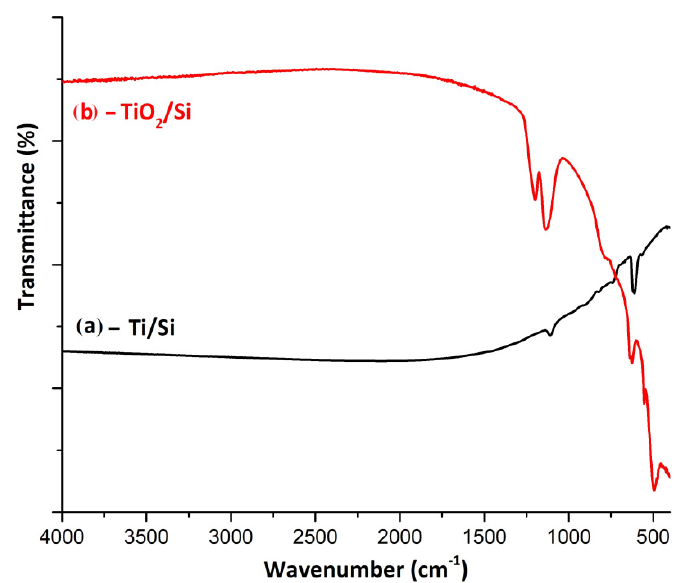
Figure 8. FTIR spectra for ( a ) a representative sample of titanium deposited on a silicon wafer and ( b ) for oxidized titanium film and heat treatment at 450 °C.